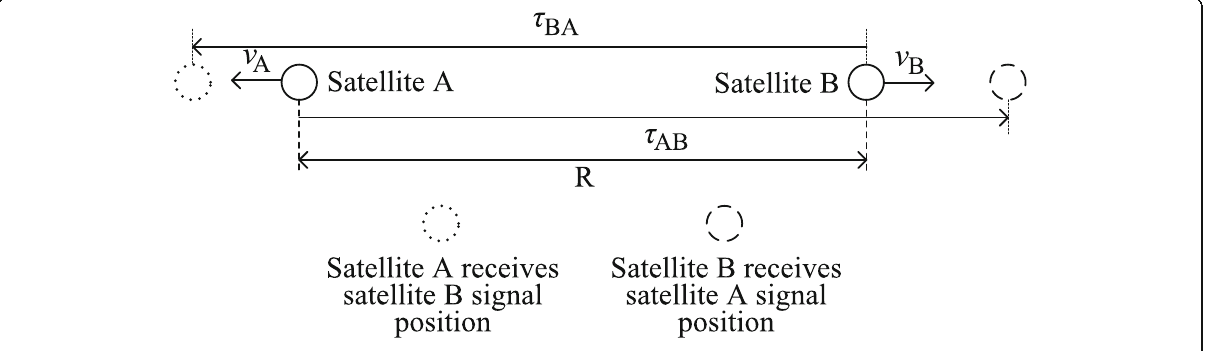
Fig. 3 Influence of inter-satellite mutual far-away motion on the measurement of inter-satellite two-way clock